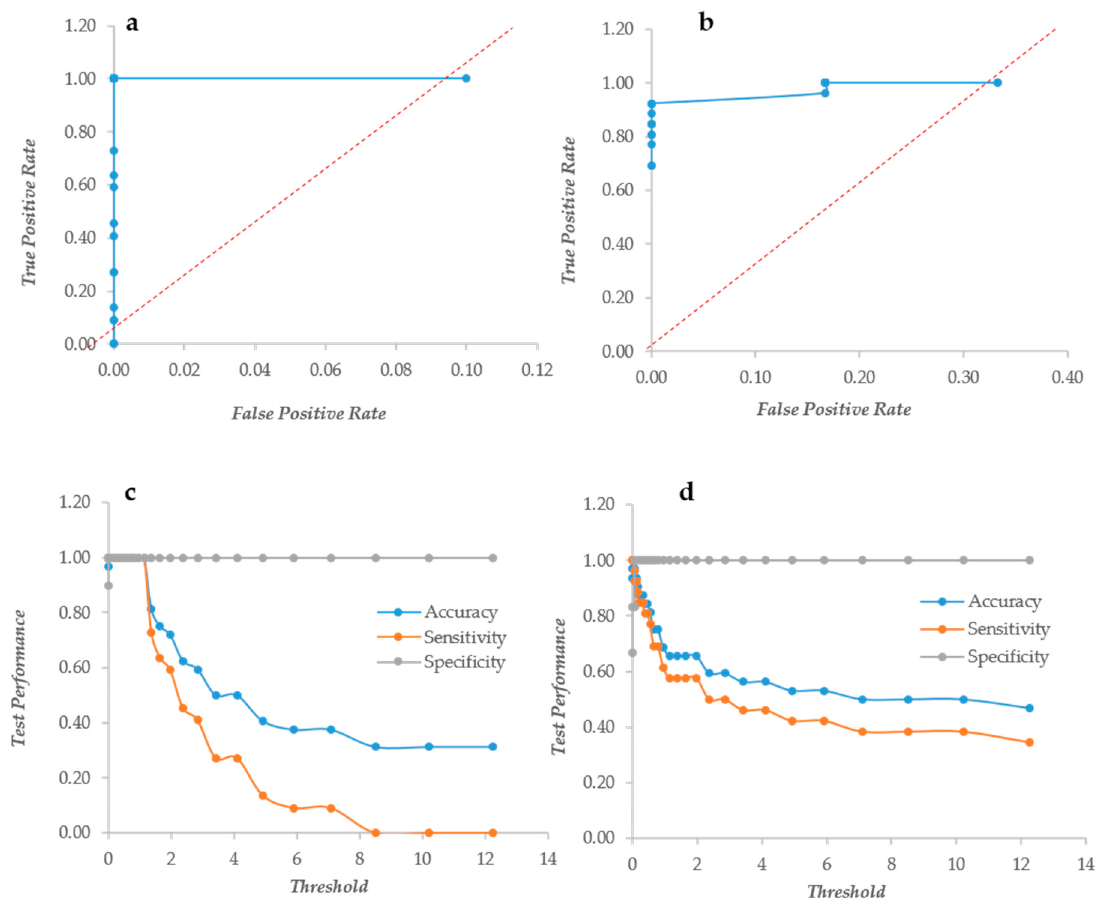
Figure 4. The Response Operator Characteristic (ROC) curves showing the ability to classify XTT and CV value products. Panels ( a and b ): the ROC curves for the CV and XTT product values of Candida and Staphylococcus respectively; panels ( c and d ): the ROC curve parameters for Candida and Staphylococcus biofilm respectively.